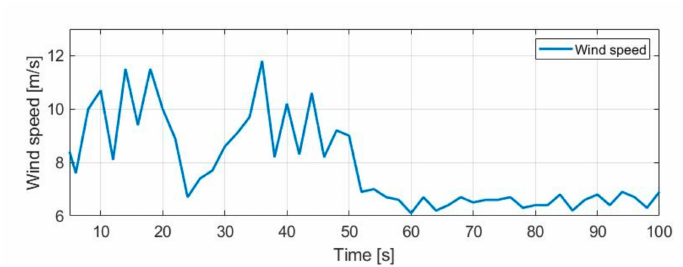
Figure 11. Wind speed (m / s) variation profile for Case 3.